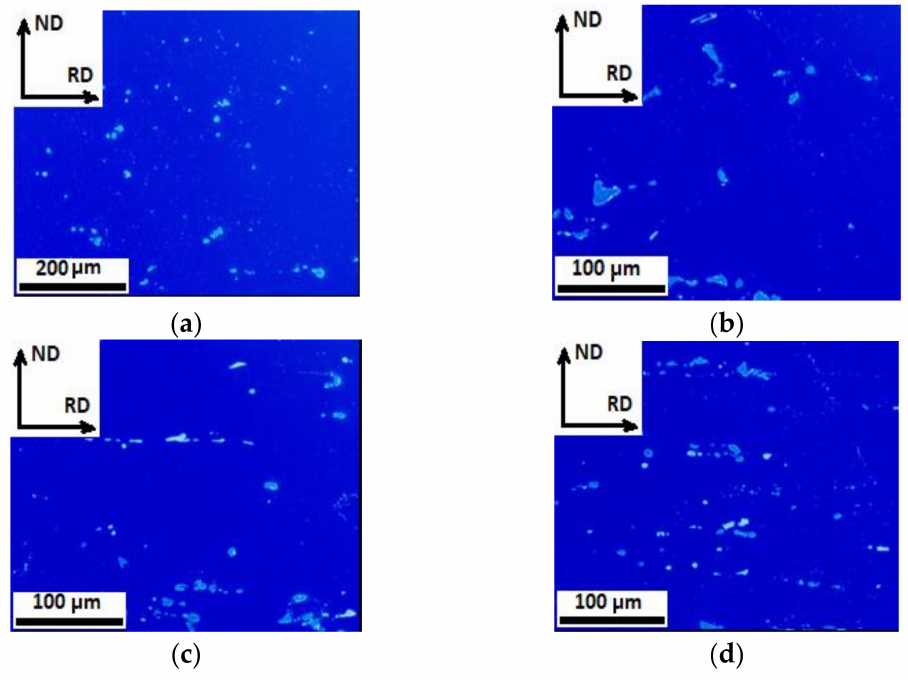
Figure 6. Micrographs of samples etched to reveal the phases of 1565 alloy: ( a ) homogenization, ( b ) 32.2% deformation, ( c ) 67.13% deformation, ( d ) 83.53% deformation.